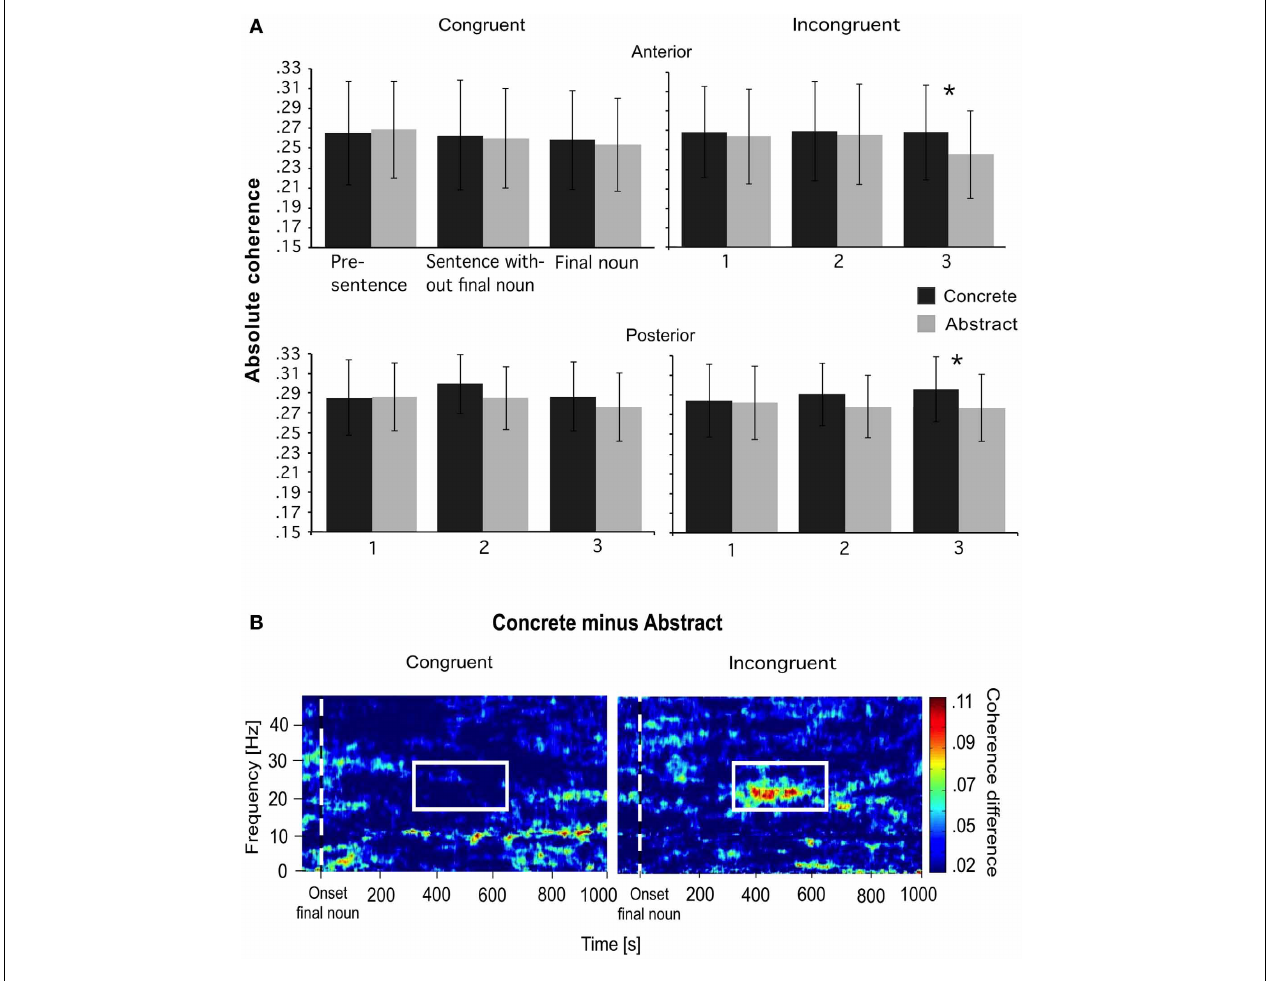
FIGURE 7 | (A) Coherence for the congruent and incongruent condition for each sentence interval at anterior and posterior electrodes. Only, the incongruent condition shows significant differences between concrete and abstract sentences in the gamma1 frequency band (interval 3). (B) An effect